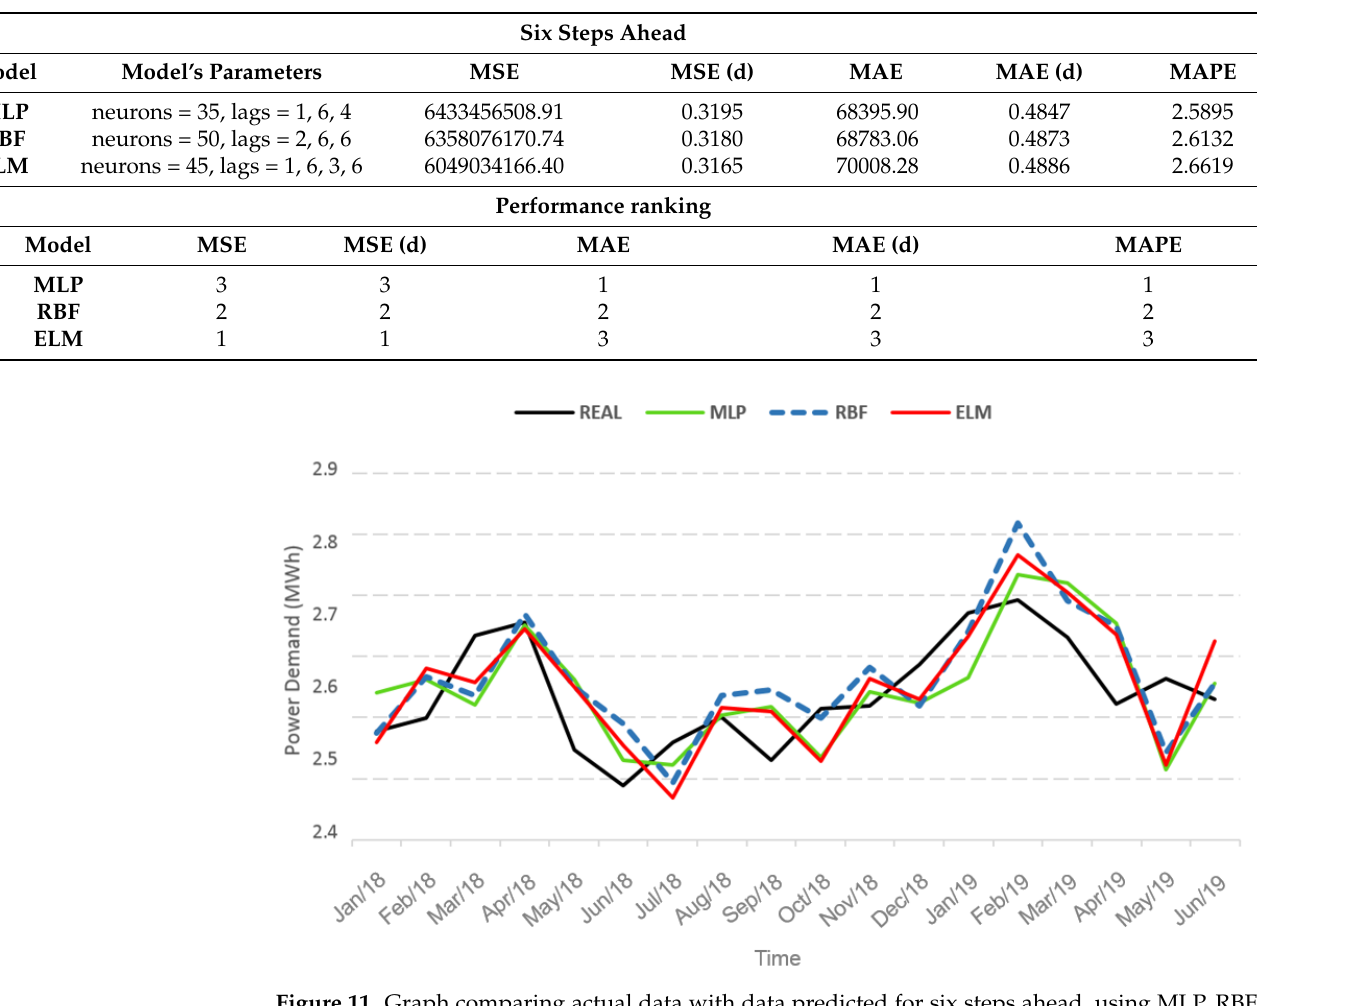
Table 19. Forecast results for six steps ahead, compared by the error measures MSE, MAE, MAPE, and their respective performance rankings.